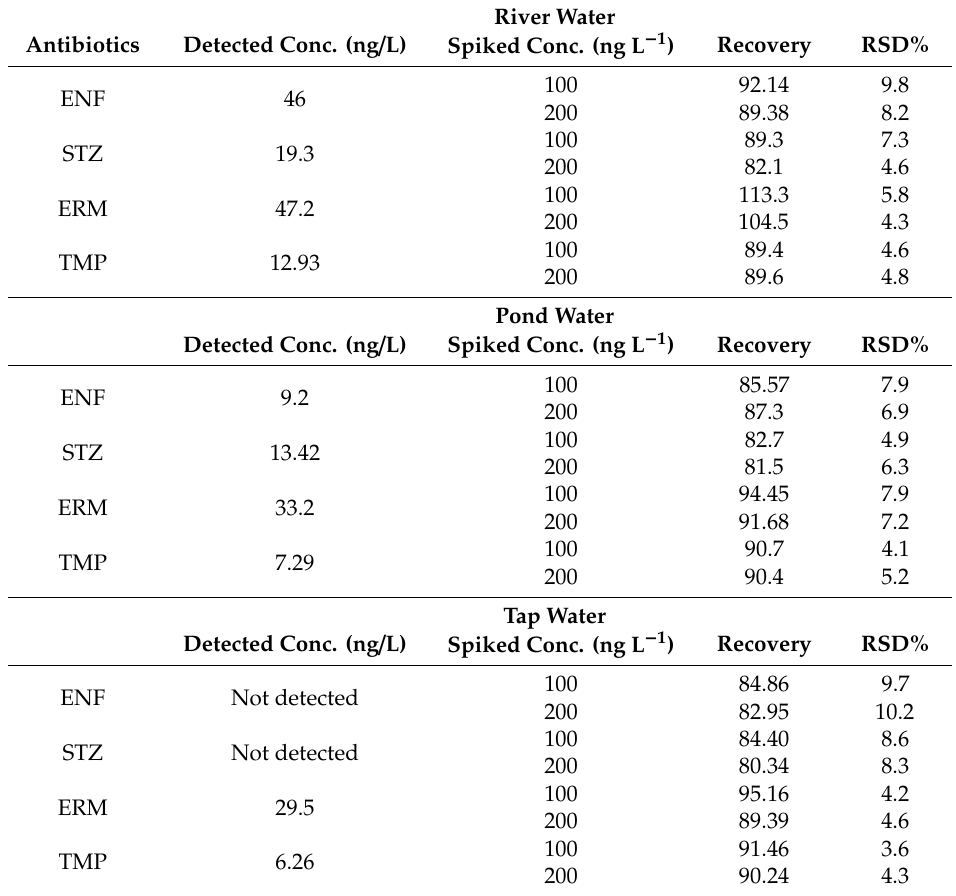
Table 2. Concentration ( µ g L − 1 ) and recoveries ( n = 3) of antibiotics at di ff erent spiked levels in real environmental